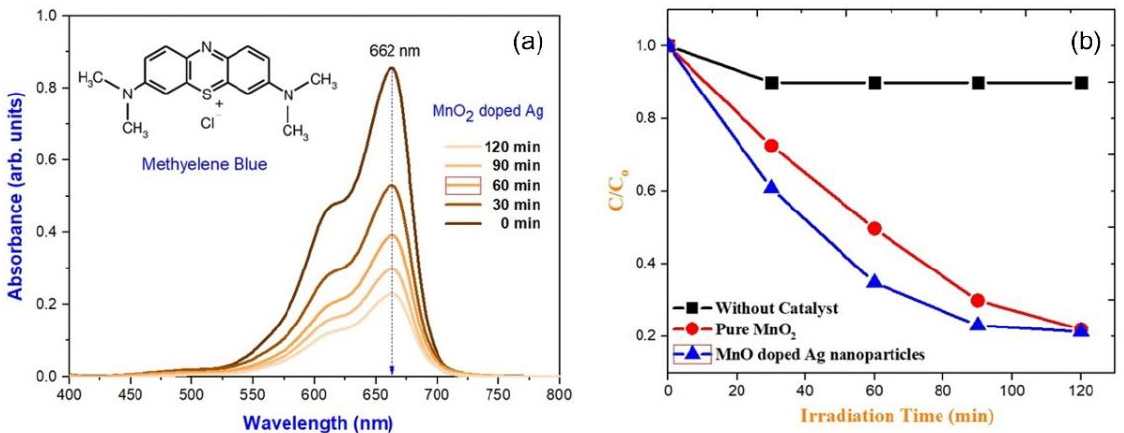
Figure 7. ( a ) UV-vis absorption spectrum of MB recorded and ( b ) the plot of C/C o vs. time for the degradation in the presence of MnO 2 doped with Ag nanoparticles.